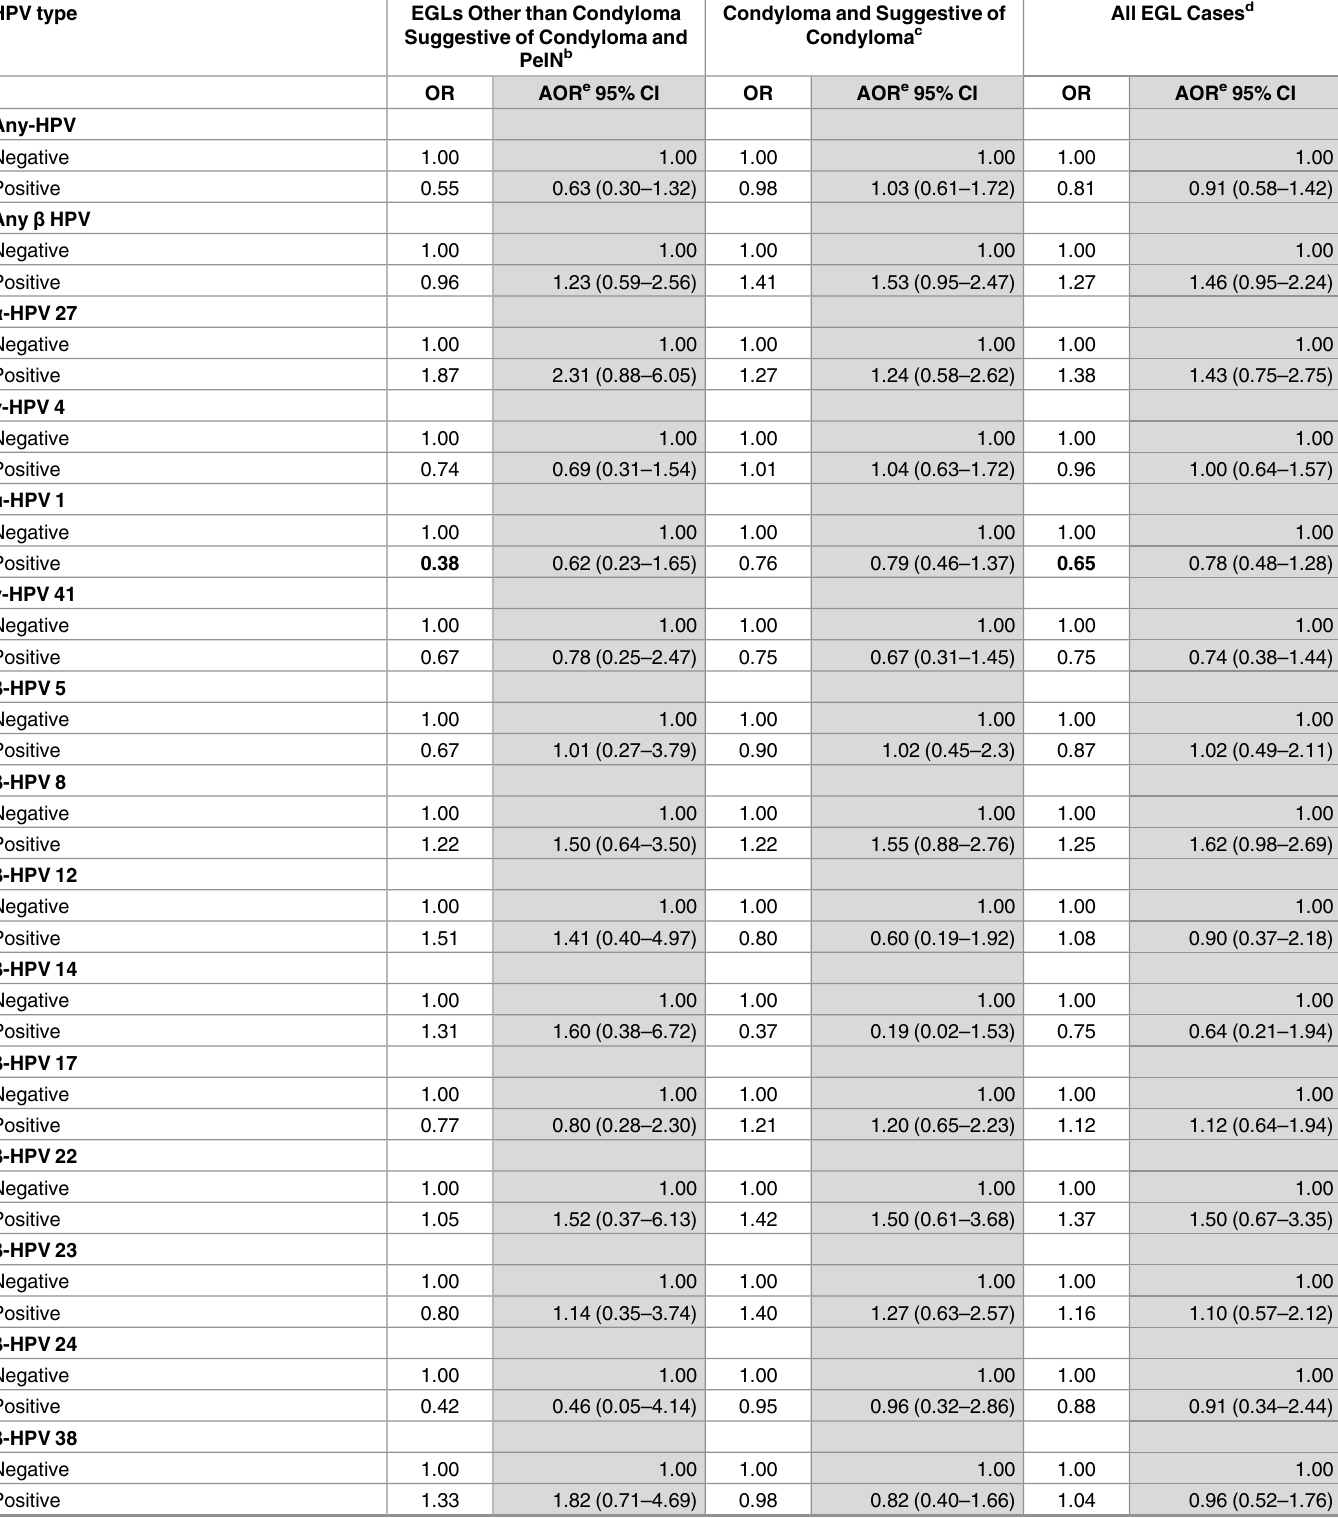
Table 3. Association between grouped and type-specific cutaneous HPV seropositivity and EGLs a